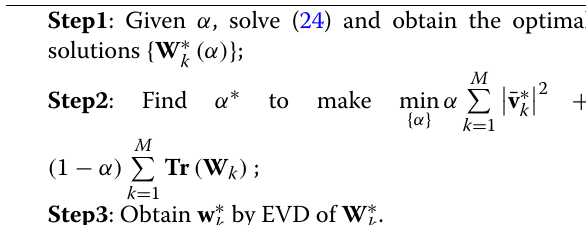
Algorithm 1 Optimal Algorithm for Problem